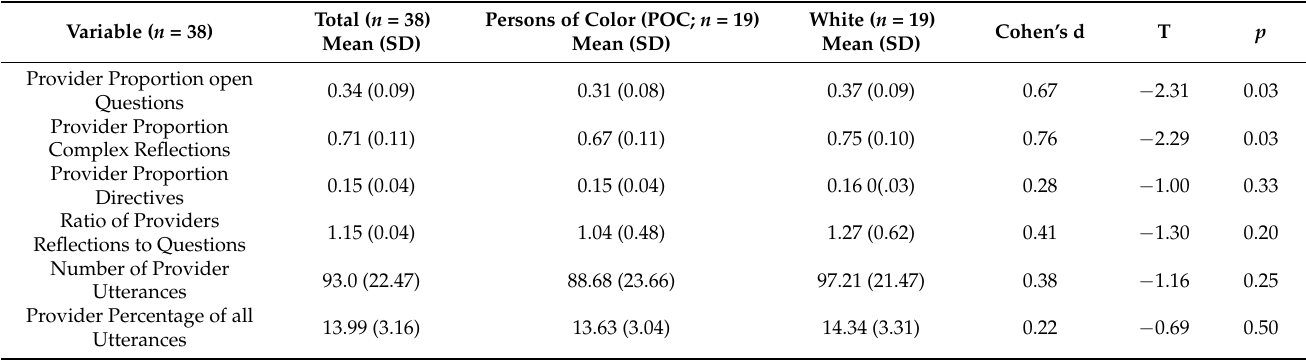
Table 3. MISC Utterances proportions.